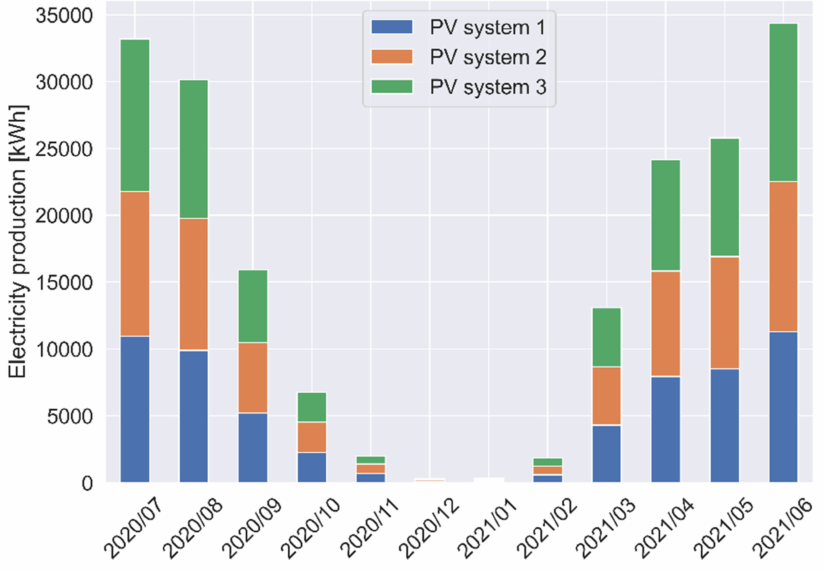
Figure 13. Monthly electricity production from PV systems.